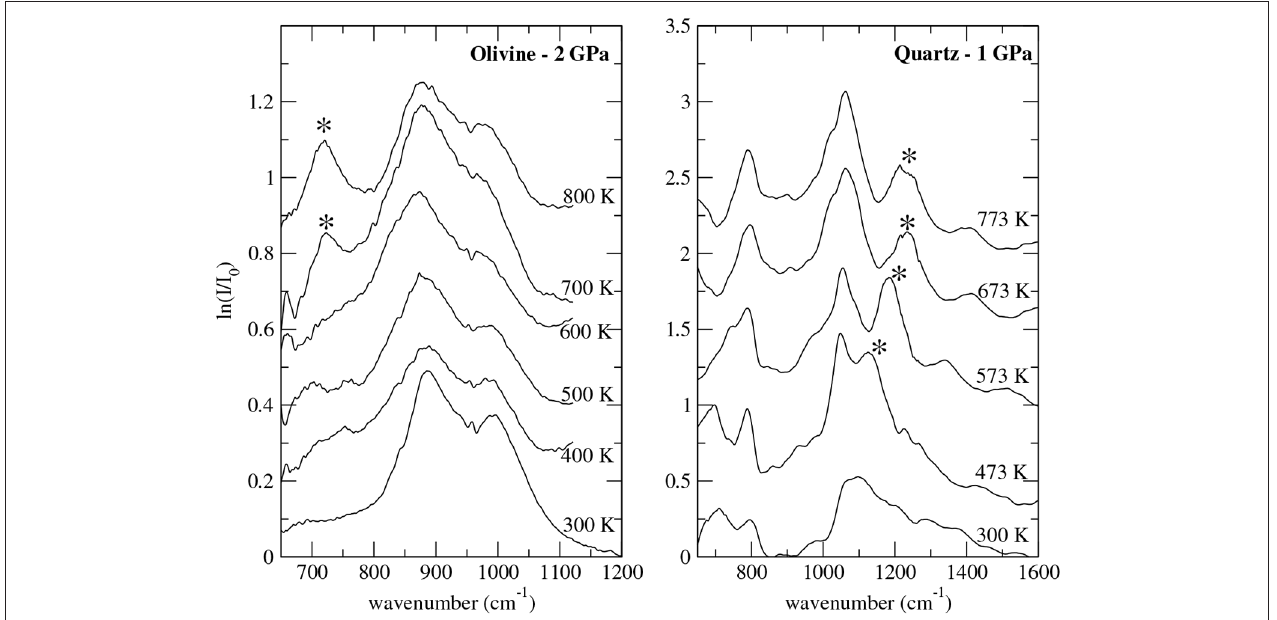
FIGURE 3 | Infrared spectra on Xe-doped silicates under high P - T conditions generated using resistive-heating diamond-anvil cells. Left: olivine, right: quartz [43]. The asterisk sign designs new vibrational mode observed only upon heating and assigned to Xe-O